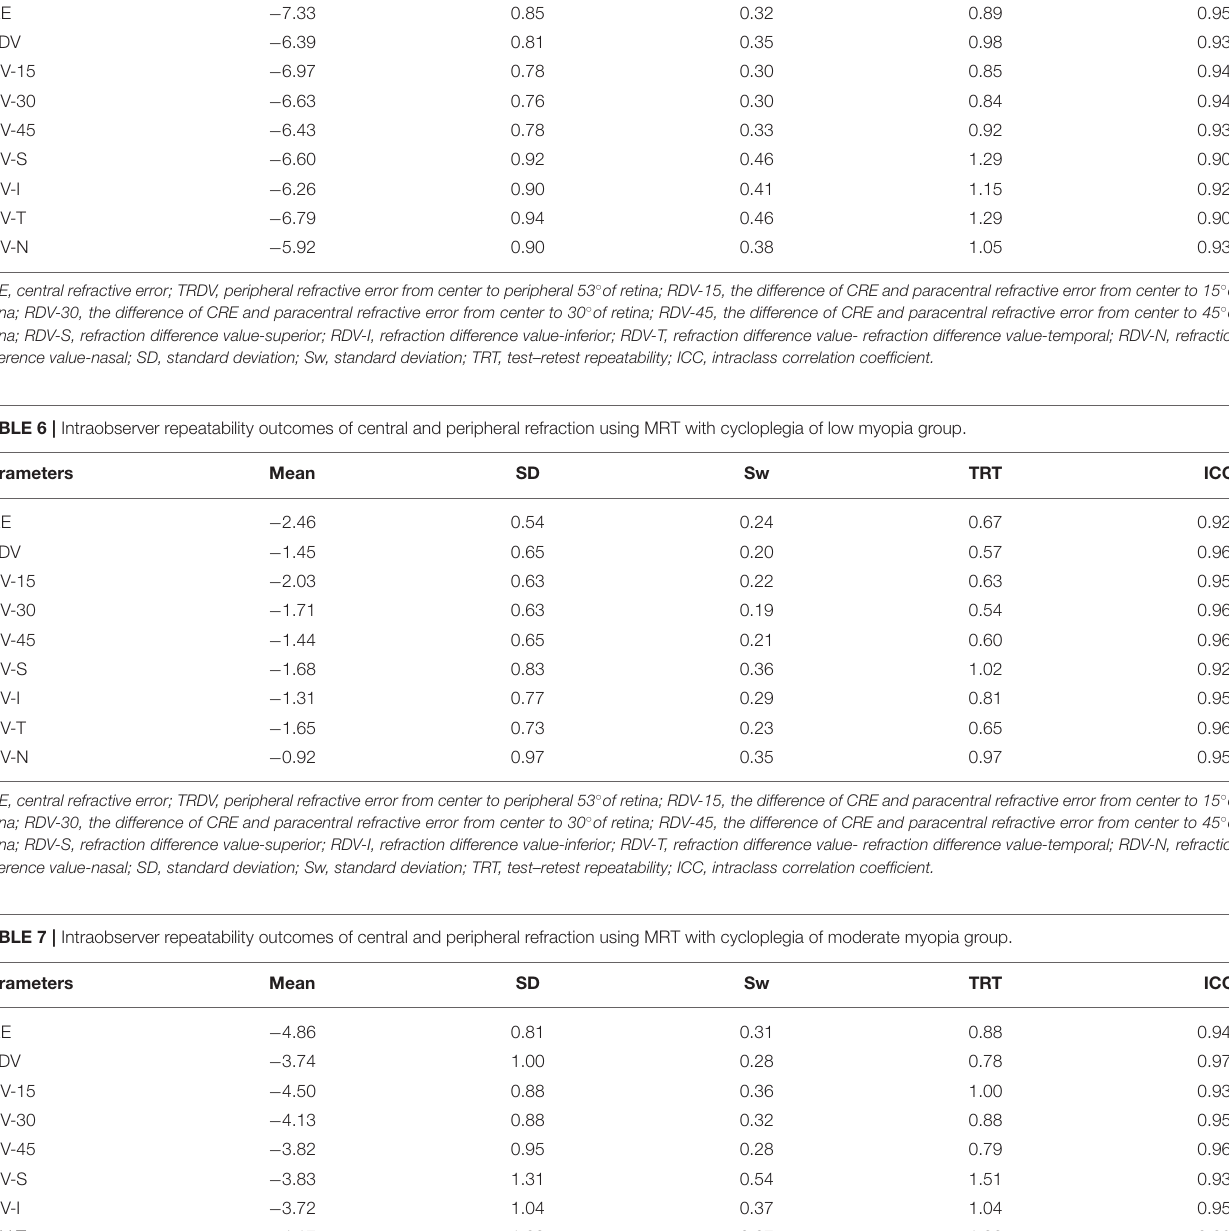
TABLE 5 | Intraobserver repeatability outcomes of central and peripheral refraction using MRT without cycloplegia of high myopia group. Parameters Mean SD Sw